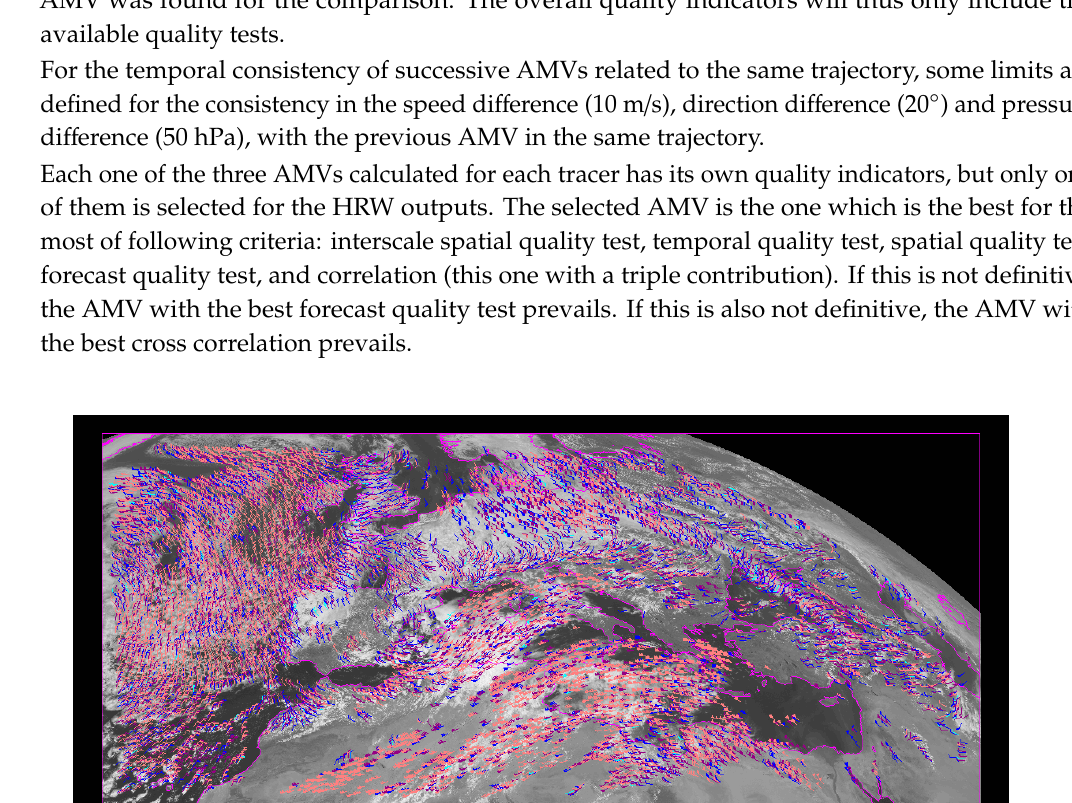
Figure 12. Common quality indicator without forecast values, for the NWC/GEO-HRW example for the European and Mediterranean region, with the default conditions for MSG satellites (14 May 2010, 12:00 UTC, MSG-2 satellite). The differences with Figure 11, and the fact that not all AMVs have a valid value for the common quality indicator without forecast are to be noticed.